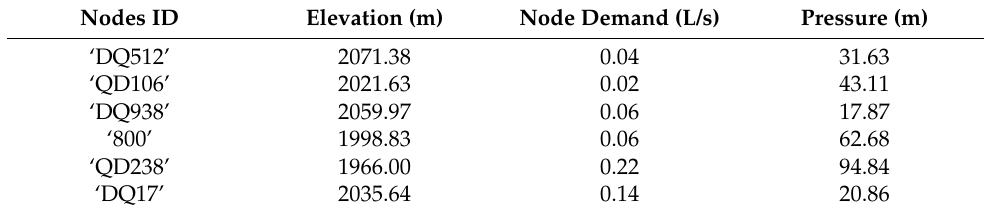
Table 5. Characteristics of critical nodes in Case